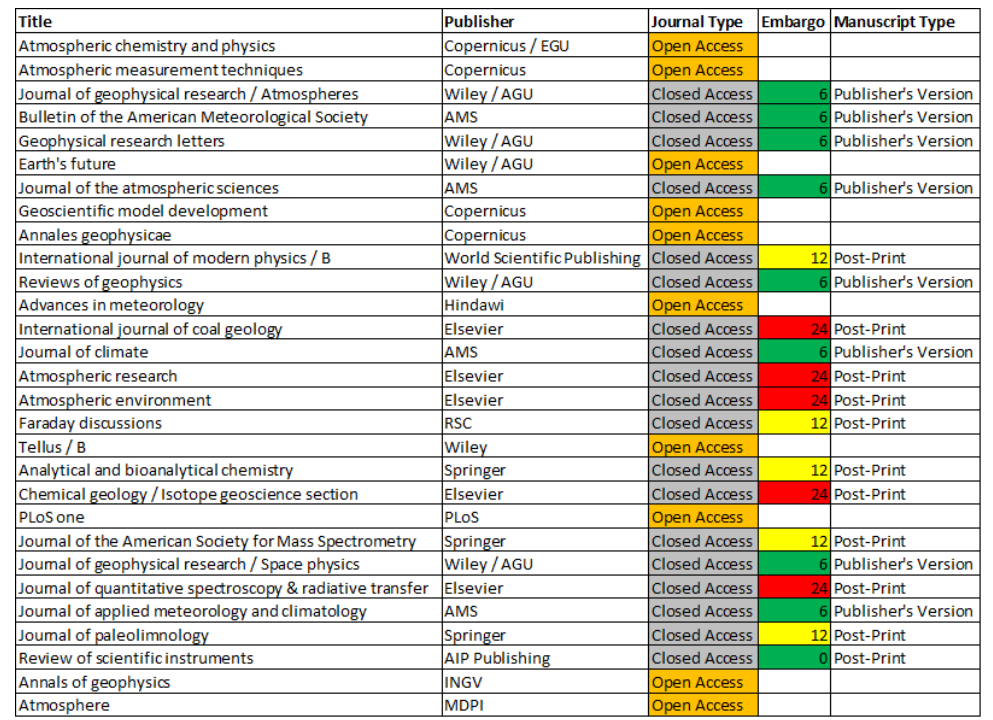
Figure 2. This figure shows an example list of the journals in which a research institute of Forschungszentrum Jülich published in recent years. This list is enriched with information on the journal type and whether green open access is possible in the case of closed access journals. The embargo period is given in months from the date of publication in the journal for the related manuscript type. Closed access journals that meet the embargo period accepted by Horizon 2020 are highlighted in green, and those that also meet the embargo period accepted by the Helmholtz Association are highlighted in yellow. Closed access journals whose embargo period is not accepted by any of the above mentioned institutions are highlighted in red. The presented embargo periods were collected in April 2018.